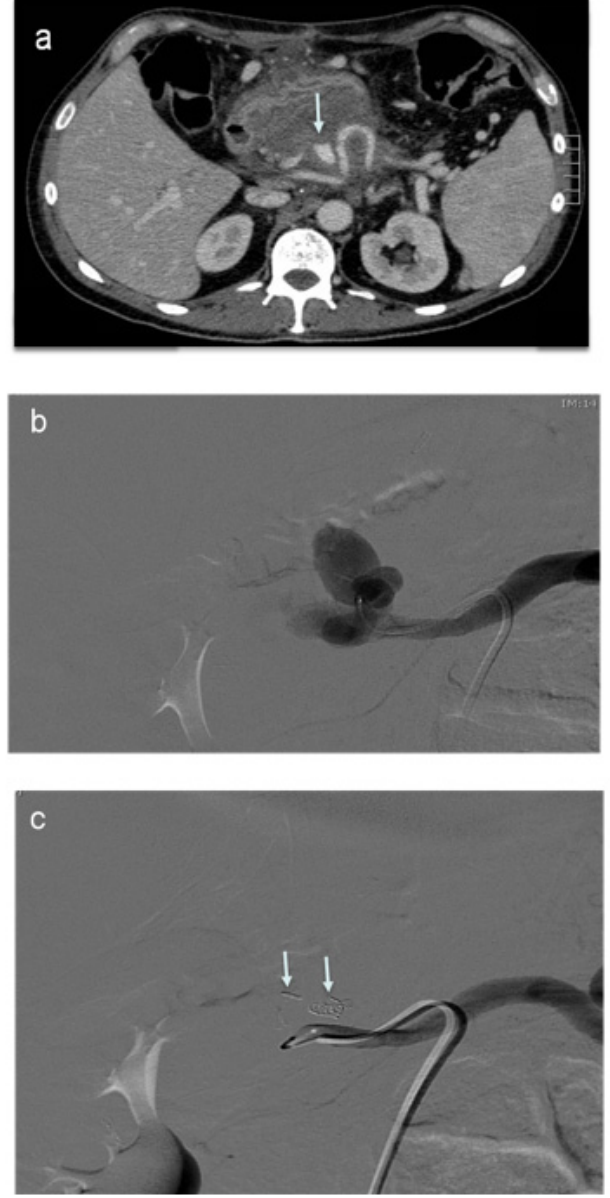
Figure 5. Splenic artery pseudoaneurysm embolization. ( a ) Contrast-enhanced CT after pancreatic surgery in a hemodynamically unstable patient shows a bleeding splenic artery pseudoaneurysm (arrow). ( b ) DSA showing a super-selective catheterization of the pseudoaneurysm using a coax- ial microcatheter. ( c ) DSA showing a total pseudoaneurysm occlusion after embolization with coils